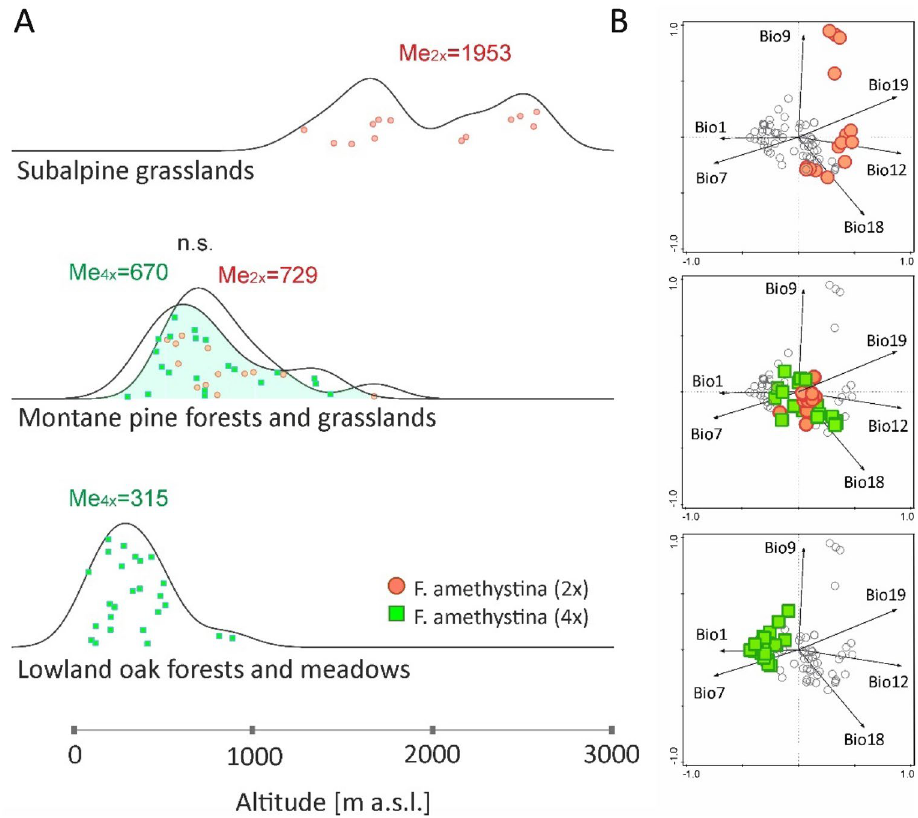
Figure 5. Differentiation of F. amethystina cytotypes according to ( A ) the main habitats and altitudinal gradient, visualized as ridgeline plots and ( B ) localities of each habitat in the PCA climatic space with a distinction between cytotypes (extracted from Fig. 3). Me 2x , Me 4x —median values of altitude in a given habitat and cytotype, n.s.—non significant statistical differences between medians according to Mann–Whitney U